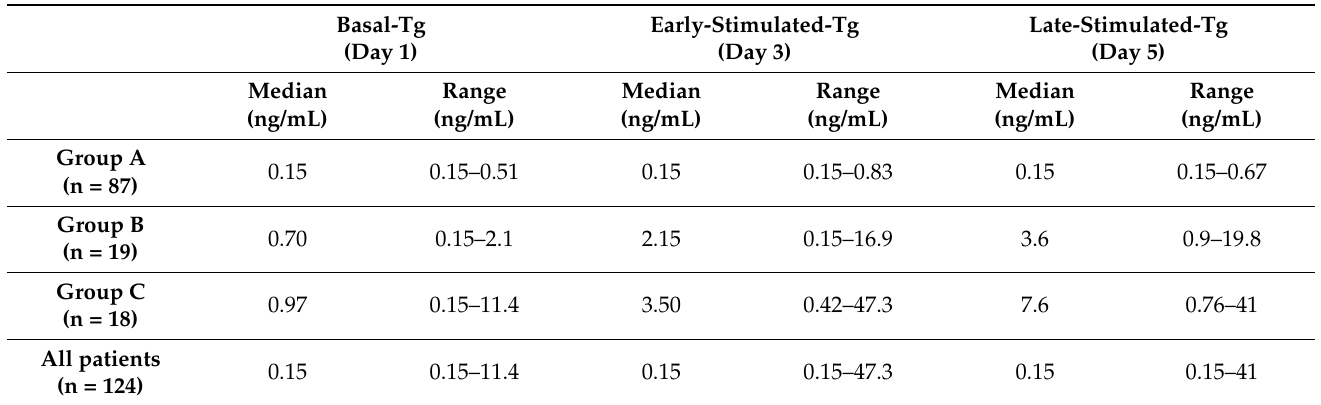
Table 6. Basal, Early and late-stimulated-Tg values of all DTC